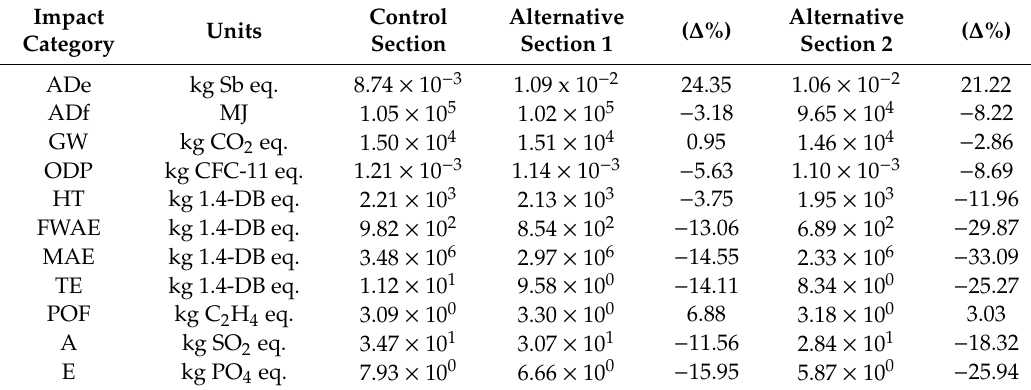
Table 9. Characterization results of